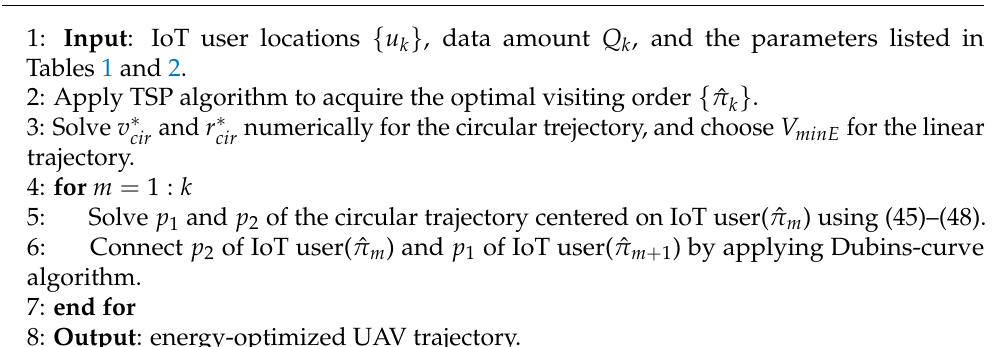
Algorithm 2 Energy-optimized trajectory planning